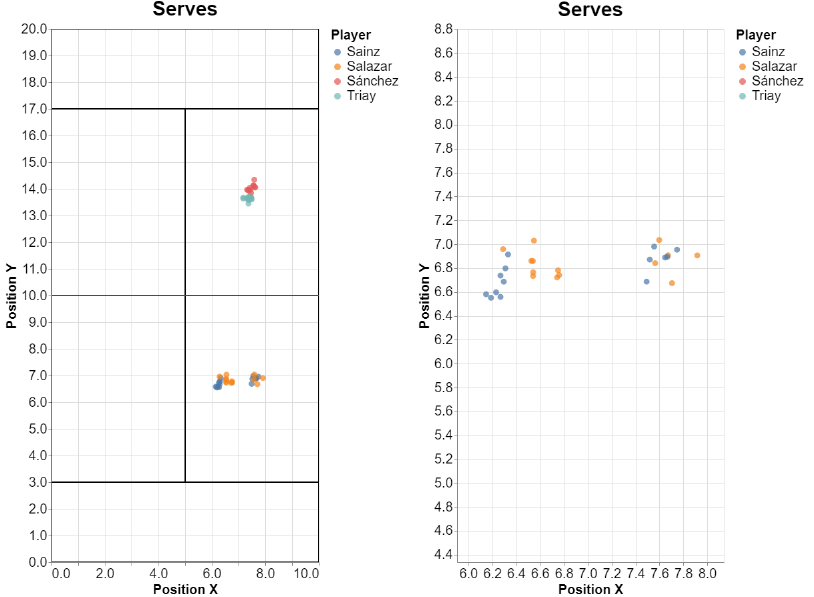
Figure 15. Position of the partner during serves (and a zoom into the clusters on the bottom